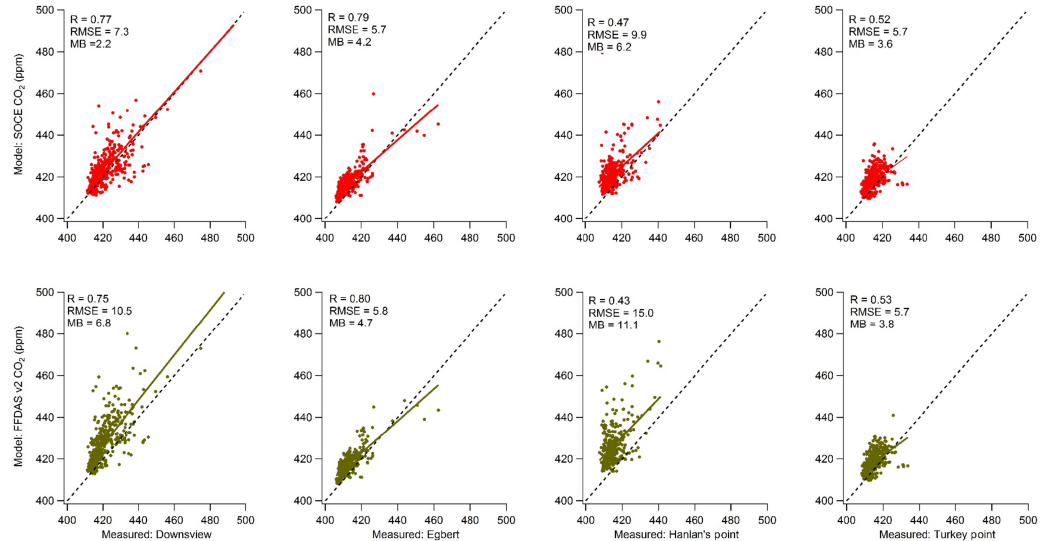
Figure 6. Scatter plot of the modelled and measured afternoon (12:00–16:00EST) CO 2 mixing ratios from January to March 2016 at the four monitoring stations used in this study. The top and bottom panels show measurement–model correlation when the SOCE inventory and the FFDAS v2 inventory were used, respectively. The model vs. measurement correlation coefficient ( R ), root-mean-square error (RMSE), and mean bias (MB) (unit: ppm) are provided within each panel. Solid lines are the standard major axis regression lines and dashed lines are 1 : 1 lines shown for